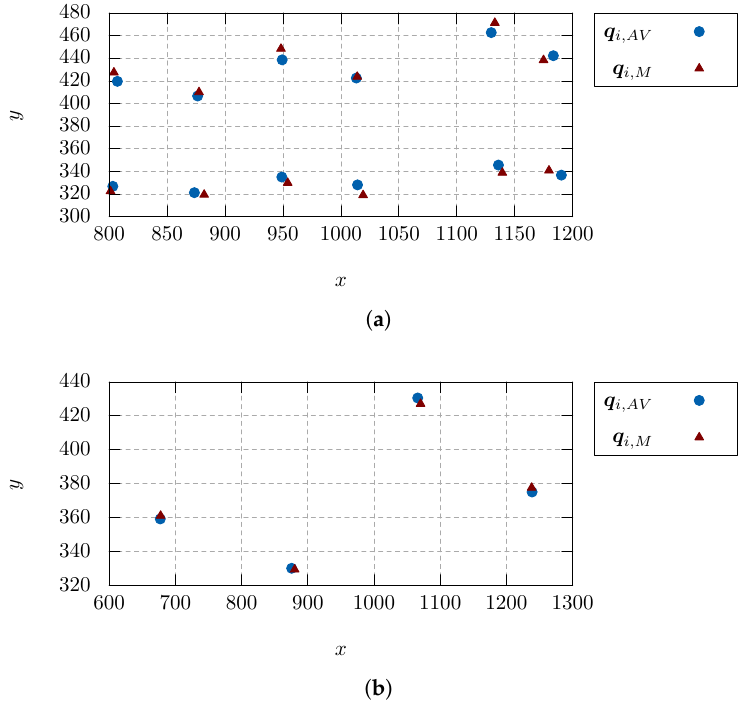
Figure 15. Keypoints discrepancy: ( a ) experiment T1; ( b ) experiment C1.